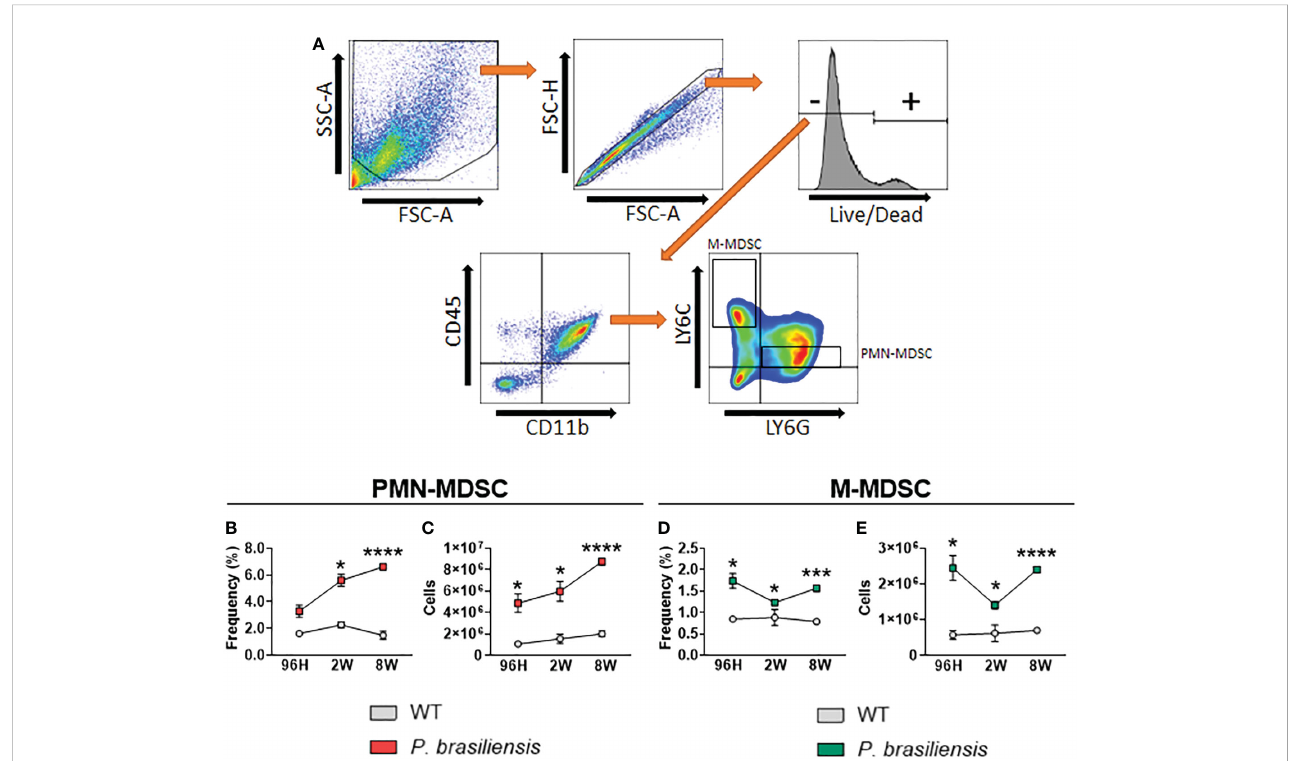
FIGURE 1 MDSC response to P. brasiliensis infection. C57BL/6 mice were infected through the intratracheal route with 1 ×10 6 P. brasiliensis yeasts. Lungs were obtained after 96 hours, 2 weeks, and 8 weeks of infection, and compared with lungs from uninfected control animals. Characterization of subpopulations was performed using speci fi c antibodies conjugated to fl uorochromes. (A) Cells were gated by FSC/SSC analysis, and populations of PMN-MDSCs (CD45 + CD11b + LY6G + LY6C low ) and M-MDSCs (CD45 + CD11b + LY6G - LY6C hi ) were represented in frequency and absolute numbers. (B-E) Data represent three independent experiments with 3-4 mice each. For comparisons between two groups, the mean ± SEM was obtained and analyzed by the unpaired Student ’ s t -test. Differences were considered signi fi cant when * p <0.05; *** p <0.001 and **** p